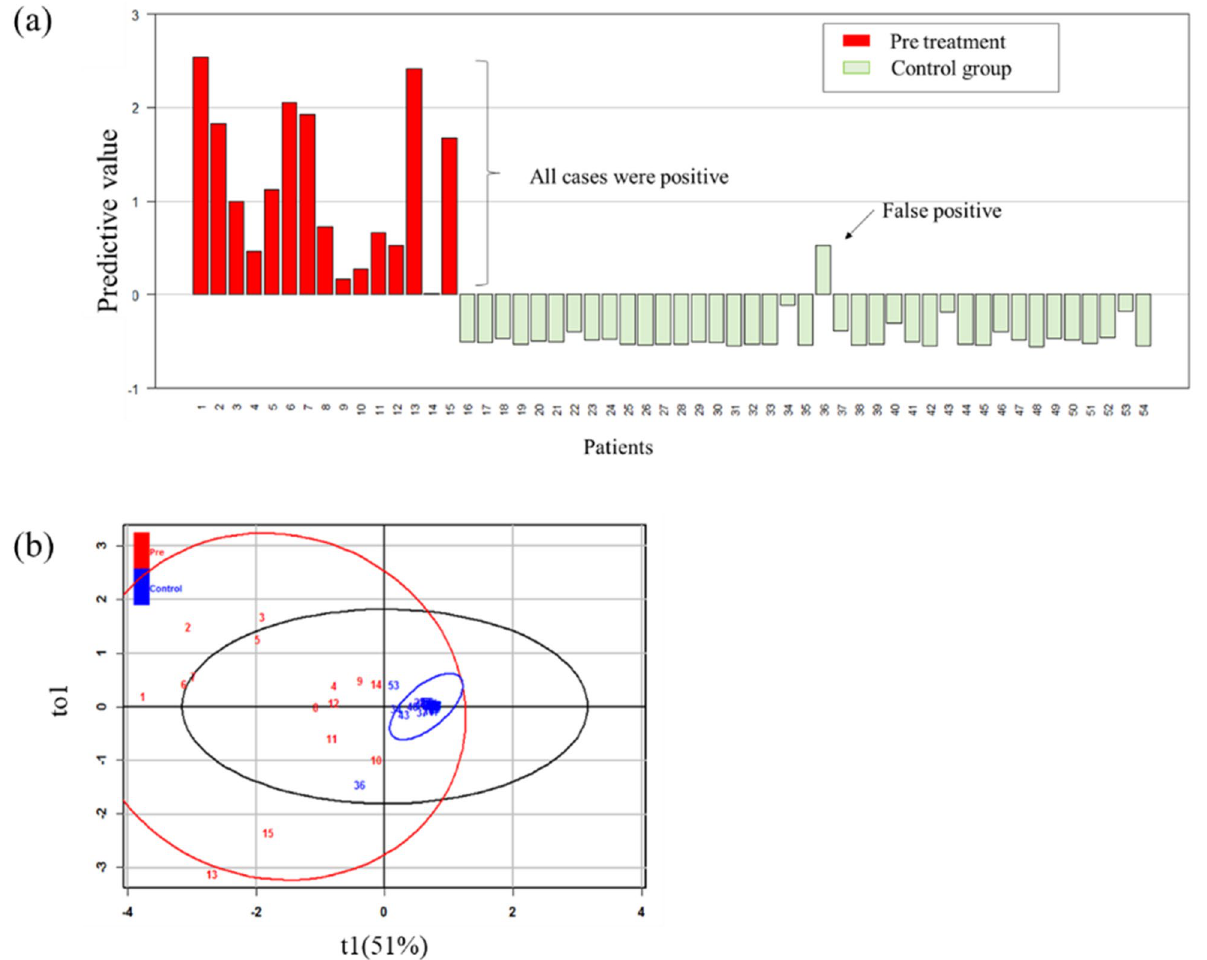
Figure 1. Predictive value analysis of the combinations of three metabolites in pretreatment patients. ( a ) Plot of the predictive values; one bar shows one sample. Positive bars indicate a positive predictive value and negative bars show a negative predictive value. Numbers 1–15 are patients and 16–54 are controls. Patient number 11 was stage 2A and 12 was stage 3. Others were stage 4. ( b ) OPLS-DA results showed that the control group formed a very narrowly scattered pattern and the tumour group formed a widely scattered pattern. The explained variation (R 2 ) was 0.726 and predictive ability (Q 2 ) was 0.687. These results show that this is an accurate model and that the control group and the tumour group are clearly